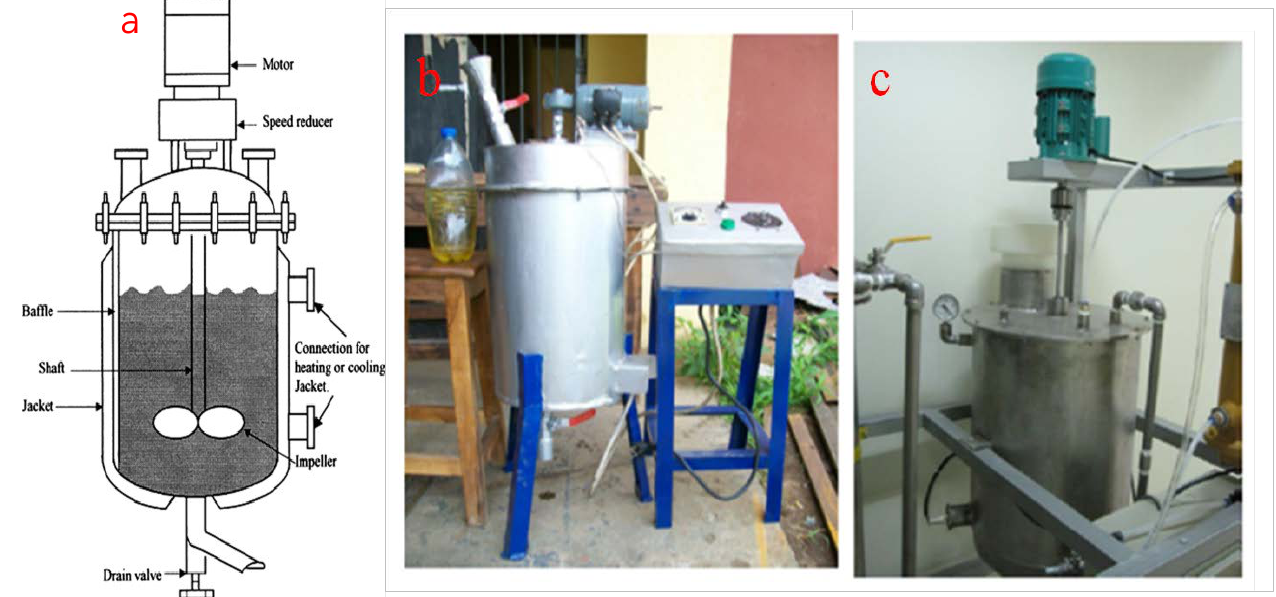
Figure 5. ( a ) Schematic representation of a batch-mode reactor. Fabricated batch-mode ( b ) 20 L; ( c ) ( a ) Schematic representation of a batch-mode reactor. Fabricated batch-mode 70 L reactor for biodiesel production. Adapted from [58,59]. ( b ) 20 L; ( c ) 70 L reactor for biodiesel production. Adapted from